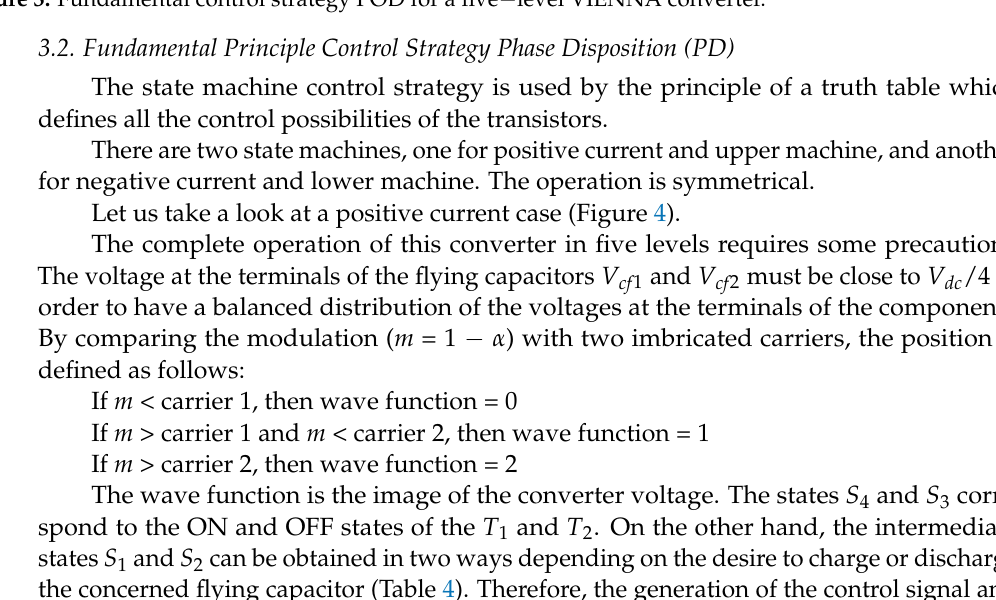
Figure 3. Fundamental control strategy POD for a fi ve − level VIENNA converter.